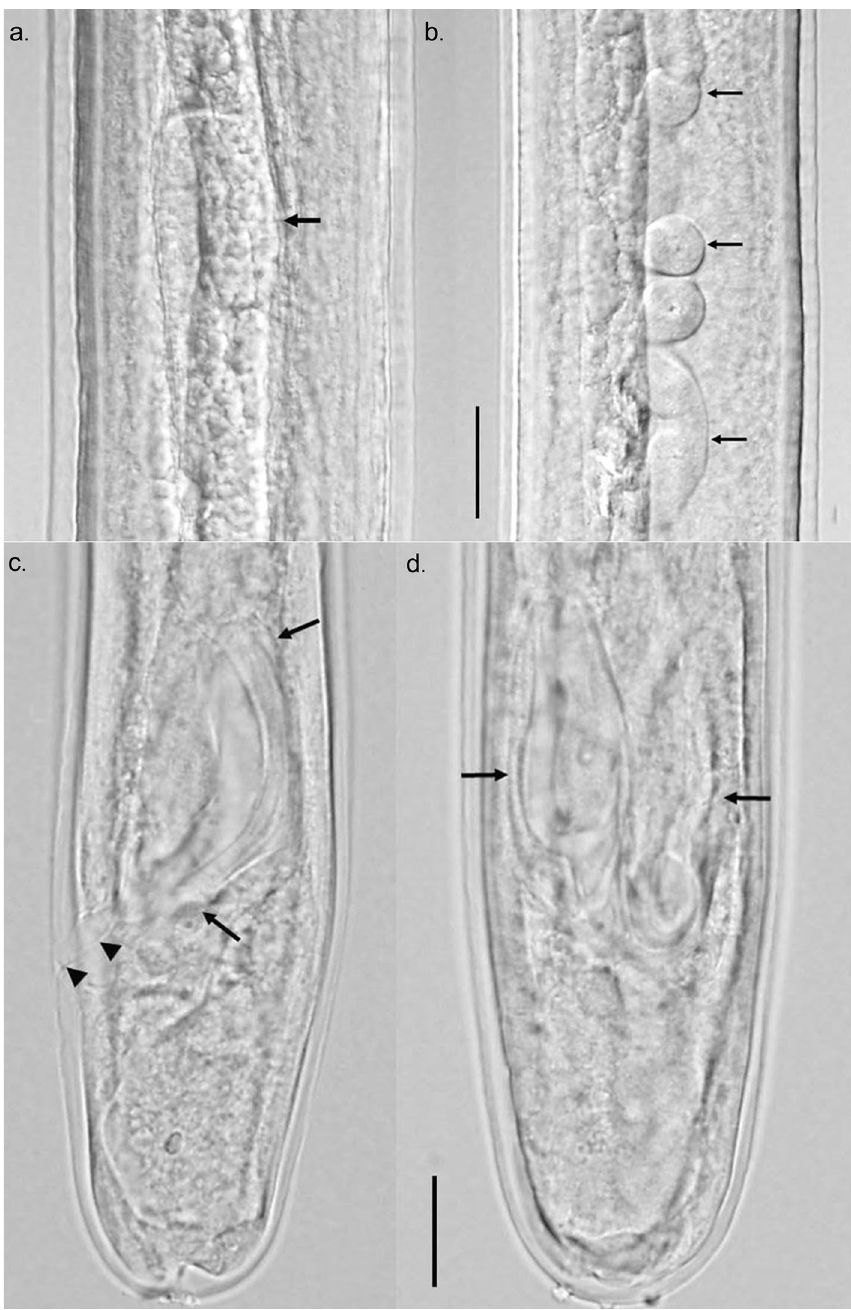
Figure 3. Differential Interference Contrast microscopy image of male larva recovered from NSG mice at 15 weeks post infection. Composite image of testis and reproductive tube. ( a ) C-shaped testis (arrow) at about midbody. ( b ) Highly coiled male reproductive tube (arrows) in posterior third of body. Scale bar 20 µm. Composite image of posterior end of male larva showing developing spicules. ( c ) Tail and one spicule (arrows) in lateral view showing size, shape and cuticularization. Cloaca and anal opening (arrow heads) also visible. ( d ) Dorso-ventral view showing both developing spicules (arrows). Scale bar 40